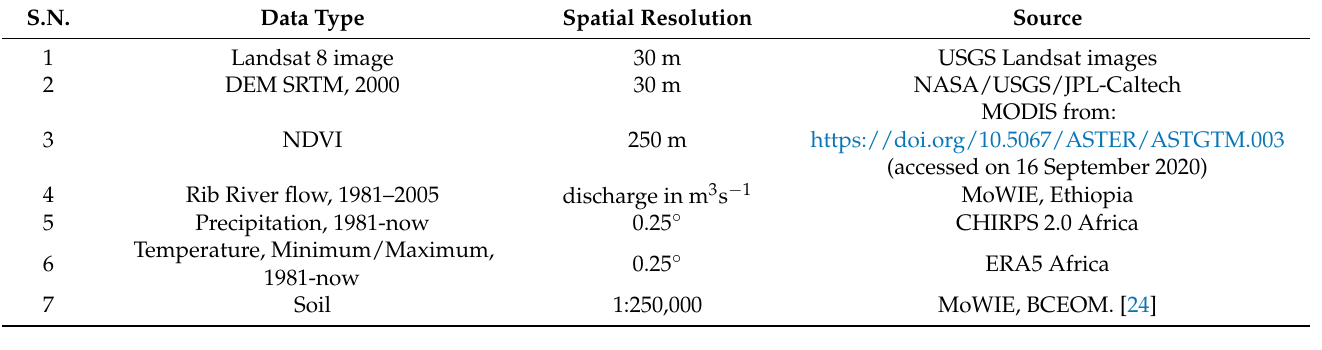
Table 1. Data type and sources.